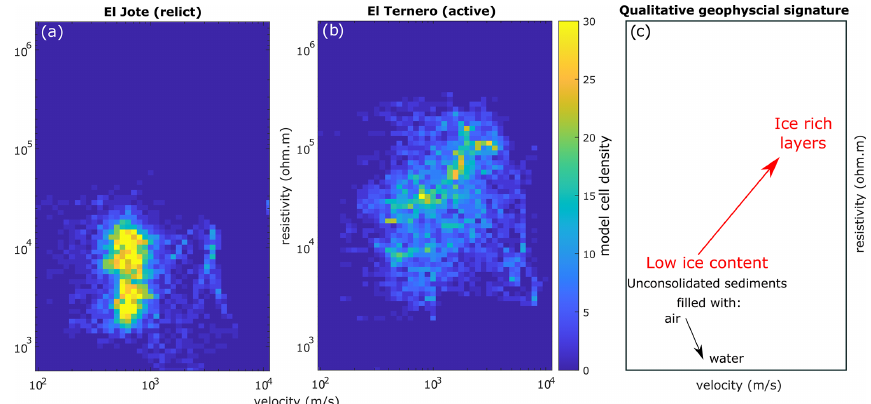
Figure 9. Density plots of resistivity versus P-wave velocity values for the (a) El Jote and (b) El Ternero datasets. (c) Schematic plot of the qualitative ERT and RST signature for intact and relict rock glaciers. The model cells involved in this analysis are inside the modelled grid, where there are ray paths and resistivity